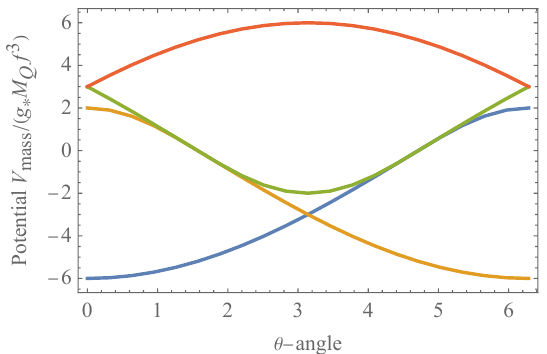
Figure 3 . Energy of the stationary points of the pseudo-Golstone potential generate by dark quark masses, eq. (3.7), in a theory with 3 degenerate (cid:13)avours. The two minima along (cid:17) (blue and yellow lines) level-cross at (cid:18) = (cid:25) so that the ground state has a cusp singularity. For (cid:25)= 2 < (cid:18) < 3 = 2 (cid:25) they are minima of the full potential. Green and red lines are always